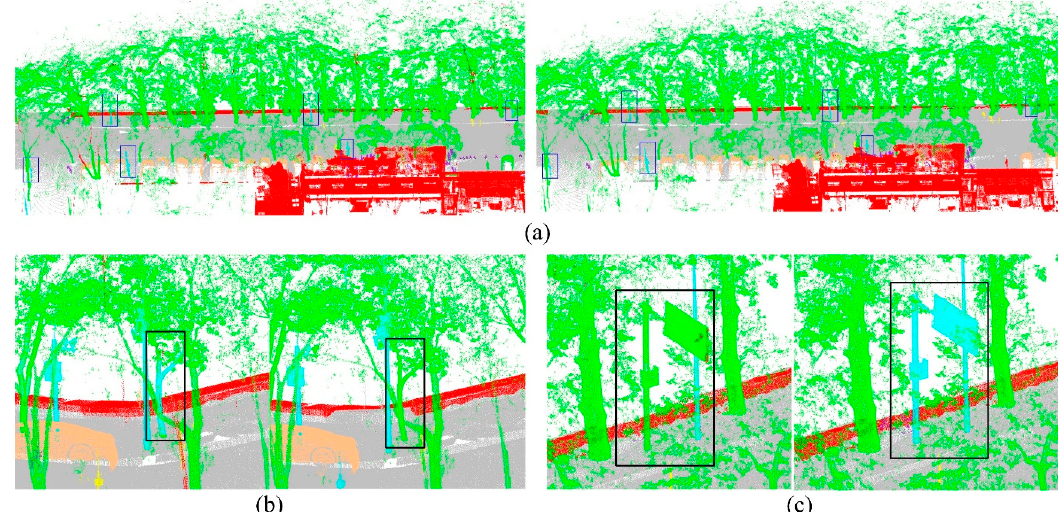
Figure 14. Pole-like object identification of the proposed method in the Wuhan University dataset. ( a ) Correct identifica- tion of a pole-like object. ( b ) and ( c ) Misidentification.